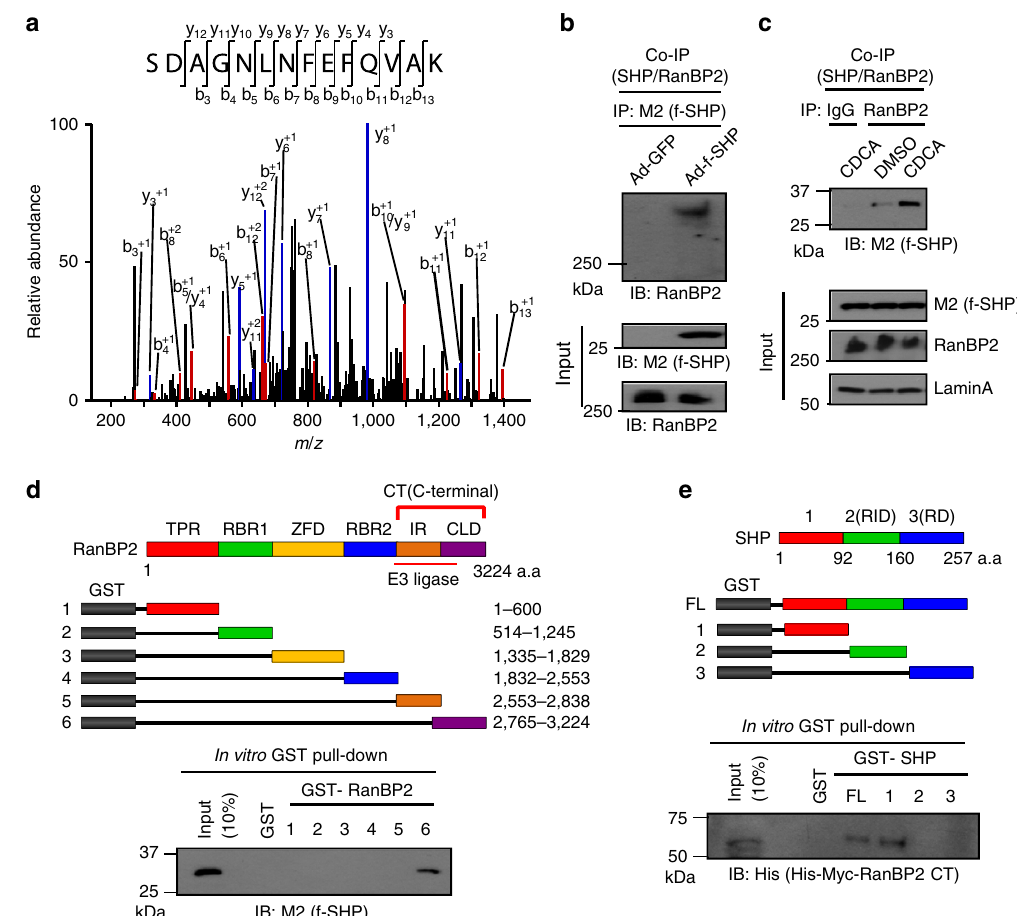
Figure 1 | RanBP2 is a novel SHP-interacting protein. ( a ) Liquid chromatography–mass spectrometry spectrum identifying a RanBP2 peptide in a flag-SHP immunoprecipitate. ( b , c ) Flag-SHP expressed in HepG2 cells ( b ) or in primary mouse hepatocytes that were treated with vehicle (dimethylsulphoxide) or 50 m M CDCA for 30min ( c ) was precipitated by M2 antibody and RanBP2 was detected in the immunoprecipitates by IB. ( d ) A schematic representation of the fragments of RanBP2 that were fused to GST (top). GST fusion proteins were incubated with flag-SHP protein and binding of flag-SHP to the GST- proteins was detected by IB with M2 antibody. CLD, cyclophilin-like domain; CT, C-terminal; IR, internal repeat; RBR1, RAN-binding domain1; RBR2,